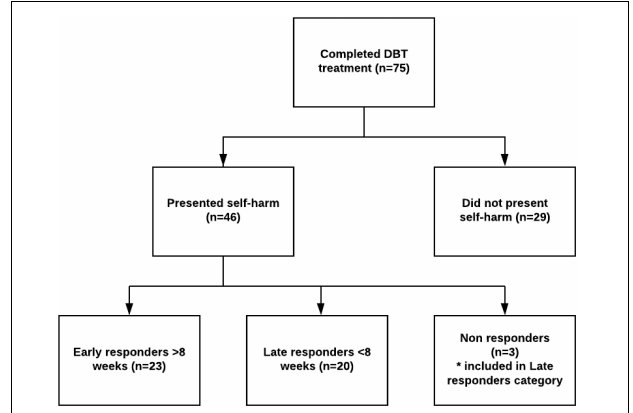
FIGURE 1 | Flow of DBT treatment completers in regard to DSH behavior cessation. Pre- and post-treatment data for all study variables were available for all patients presenting with